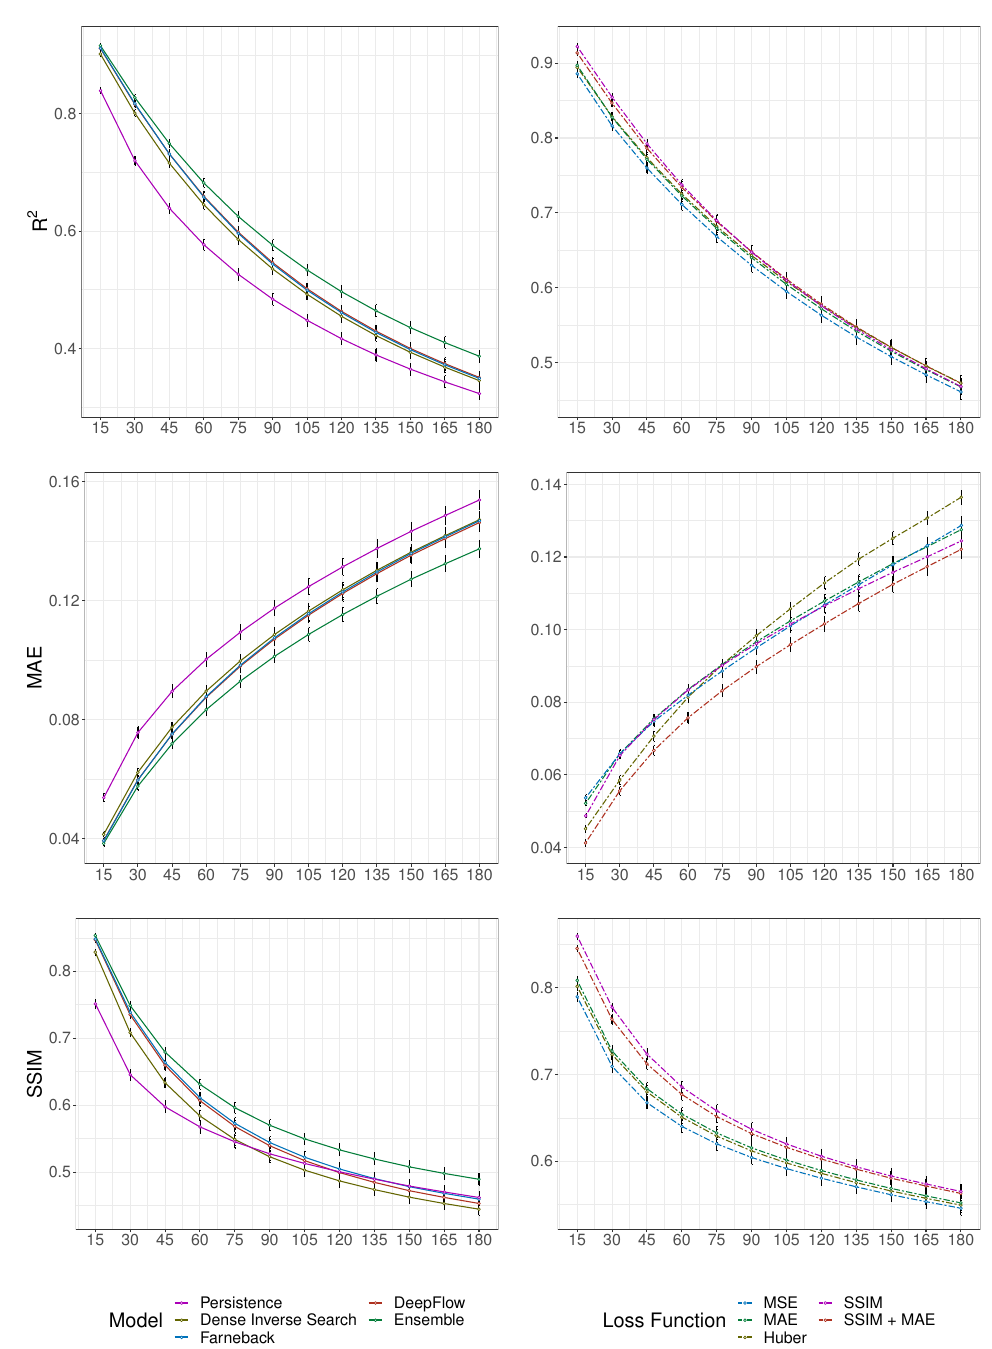
Figure 4. A comparison of average model performance across all lead times in the test set, for all optical flow models and the persistence baseline ( left ) and the ConvGRU based models with varying loss functions ( right ). Results show cumulative mean accuracy metrics per lead time in